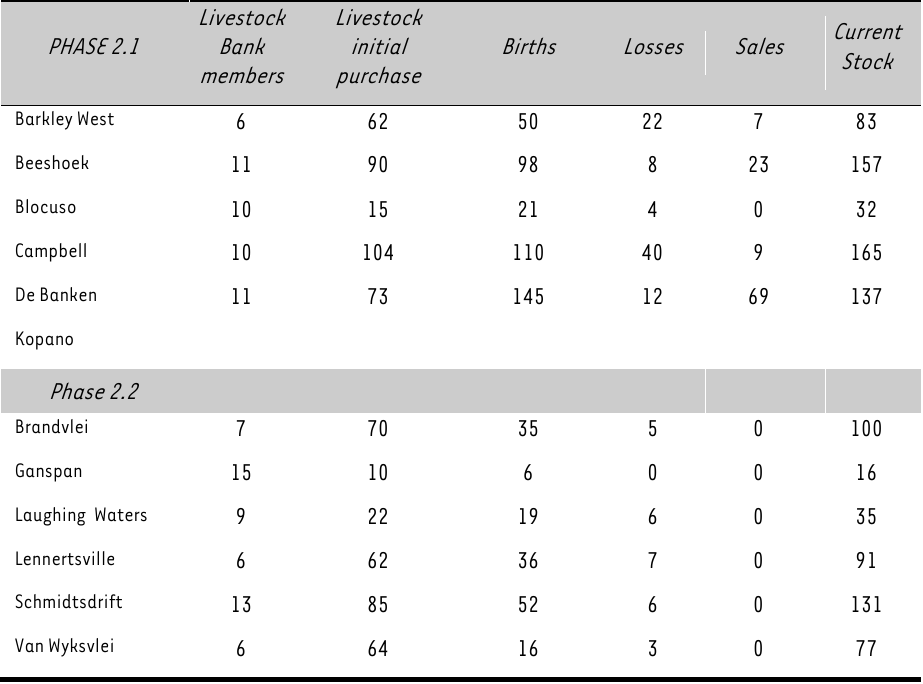
TABLE 5: Livestock situation, September 2006 PHASE